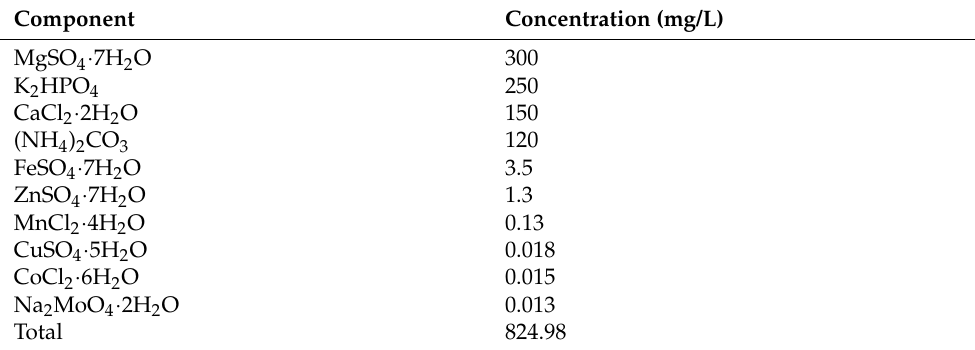
Table 2. Composition of the mineral salt medium [21].